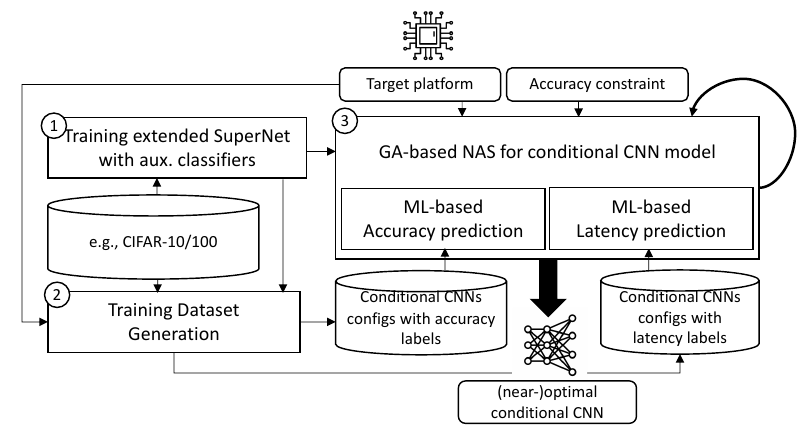
Figure 1. CondNAS overall structure and design